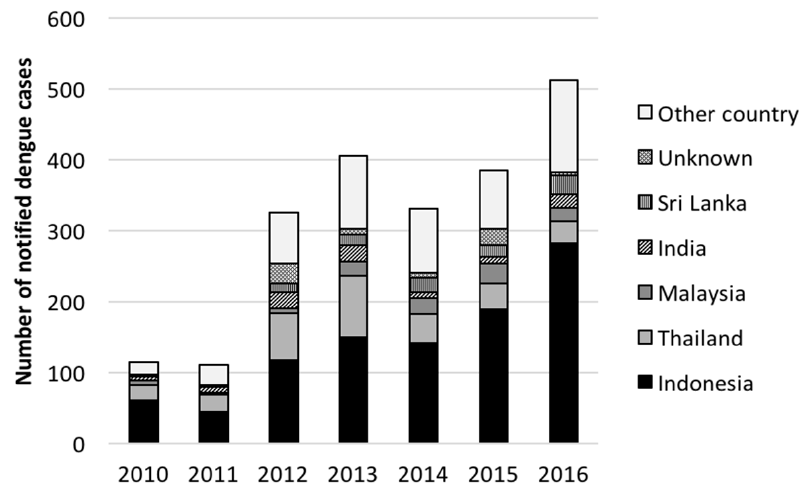
Figure 3. Number of notified cases by year and country of acquisition, Victoria 2010–2016. Table 1. Change in dengue notification incidence per year, Victoria 2010–2016.